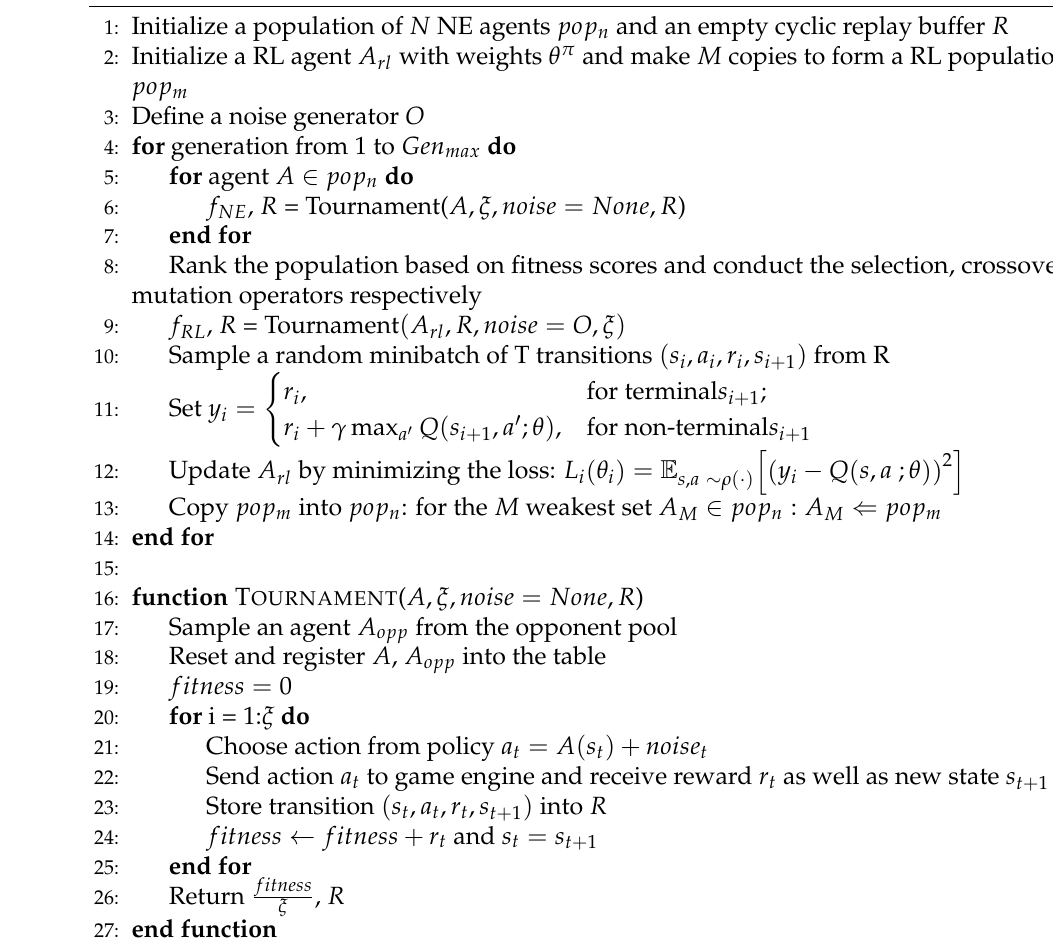
Algorithm 1 Main procedure of